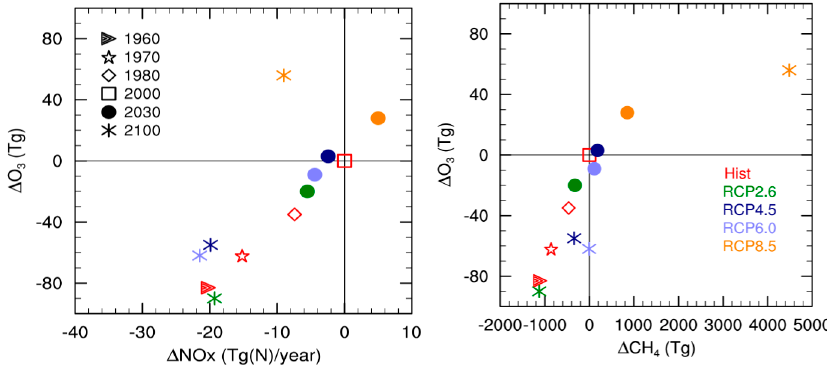
Figure 3. Change in tropospheric ozone burden compared to the year 2000 as a function of ( Left ) changes in total NO x emissions and ( Right ) changes in the tropospheric CH 4 burden as simulated by SOCOLv3. Different colors represent the different scenarios, whereas different symbols represent different years.